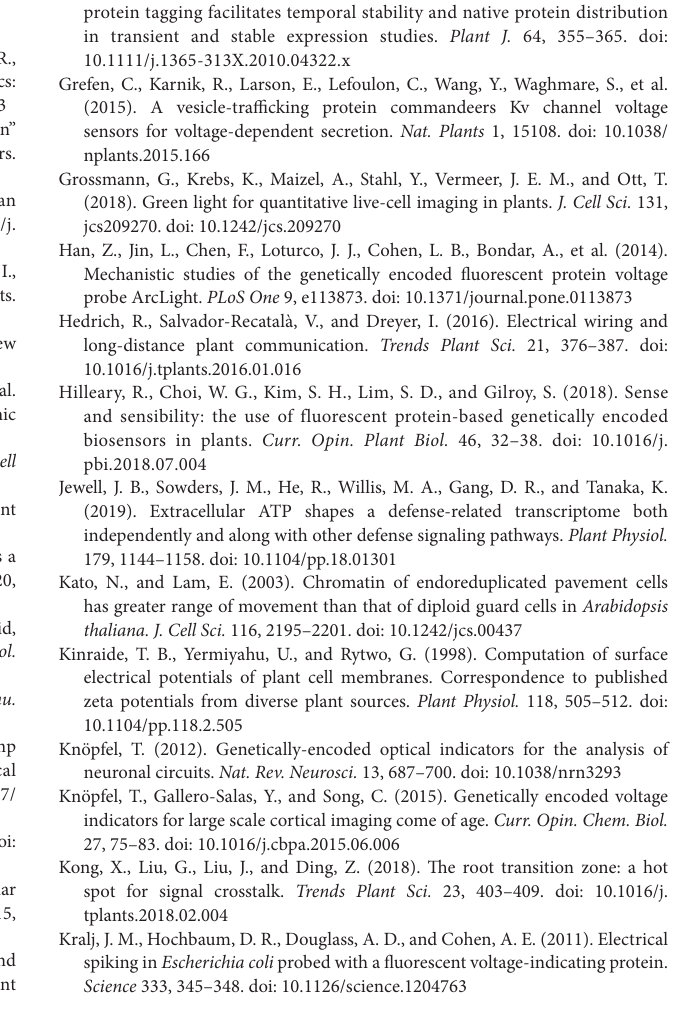
SUPPLEMENTARY VIDEO 1 | Dislocation turbulence_Figure3C_front view. avi: locus 16:112 (green), 30 minutes (in Video reduced to 6 secs: 5 acquisition points /sec, +ATP at time point 13 during red channel acquisition), P﻿ and IN﻿ colored in red (CBL1-mApple and SUN2-mApple respectively) SUPPLEMENTARY VIDEO 2 | Dislocation turbulence_ side view of Video1 SUPPLEMENTARY VIDEO 3 | Chromatin ‚jiggling‘ Figure1B_right.avi : locus 5:106 (green), locus 16:112 (red), 10 minutes (in Video reduced to 2 secs: 5 acquisition